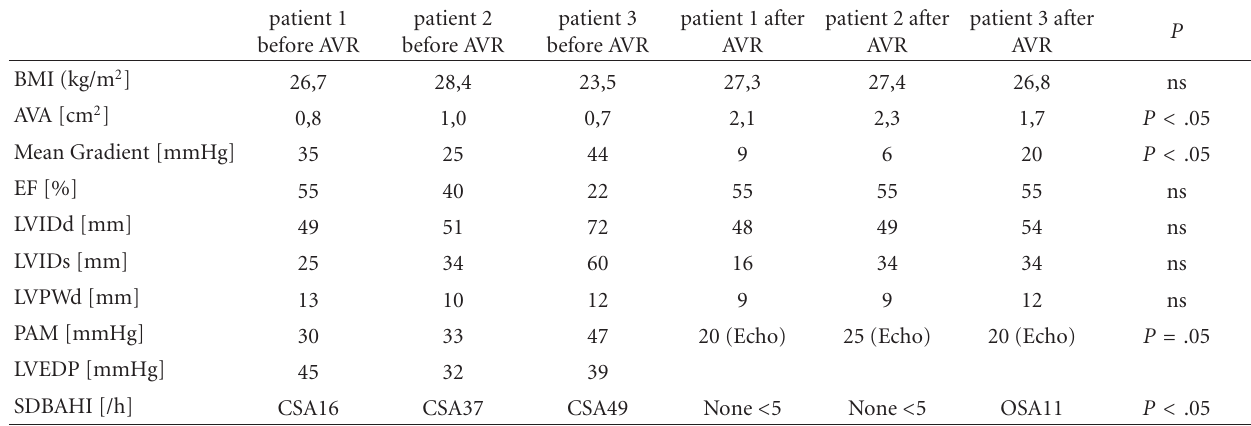
Table 1: Clinical, hemodynamic, echocardiographic, and sleep data before and after aortic valve replacement (AVR). BMI: body mass index, AVA: aortic valve area, EF: ejection fraction, LVID(d/s): left ventricular diameter (end diastolic/end systolic), LVPWd: left ventricular posterior wall thickness, PAM: mean pulmonary artery pressure, LVEDP: left ventricular enddiastolic pressure, SDB: sleep disordered breathing, AHI: